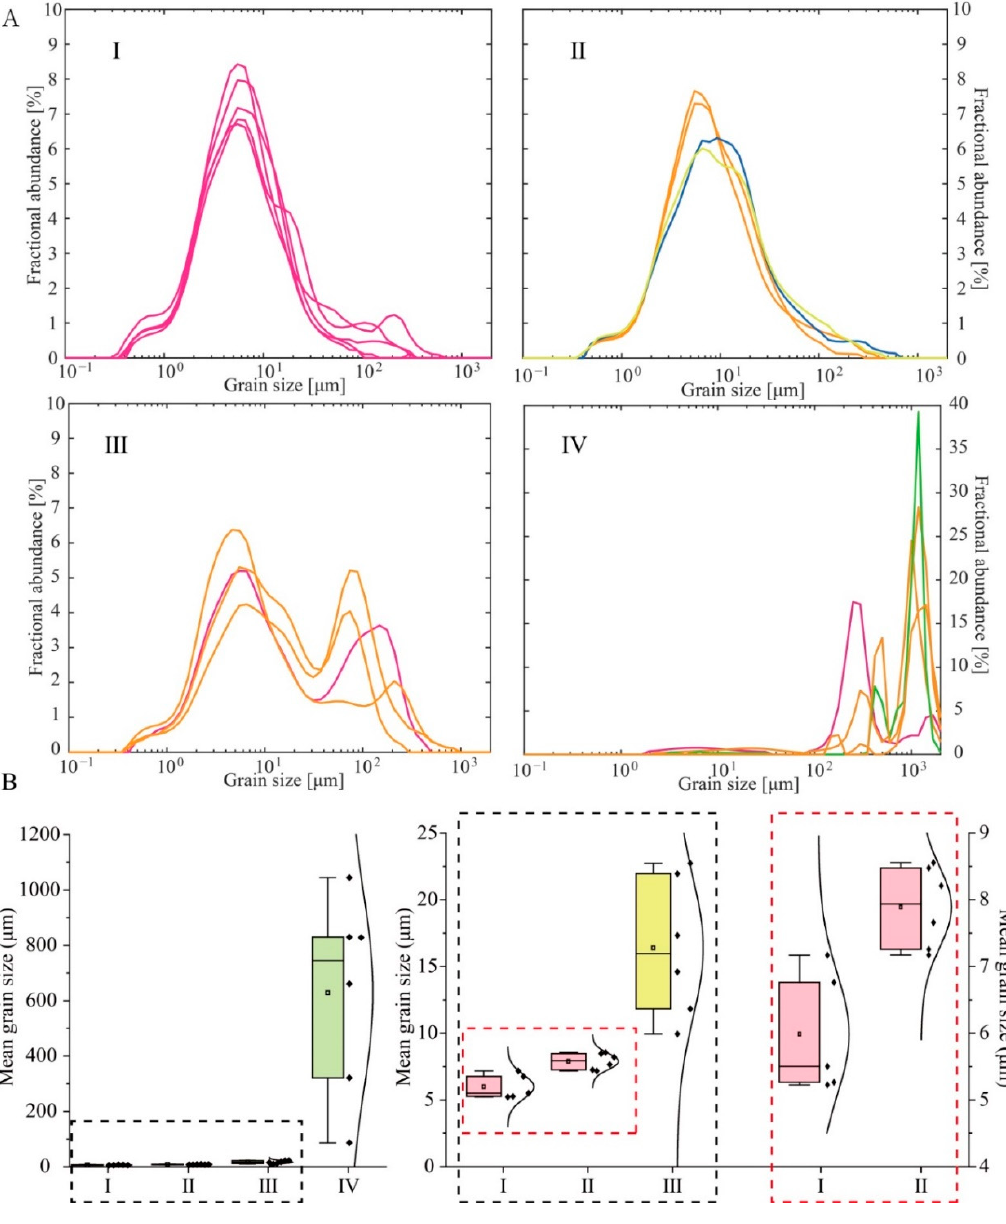
Figure 4. Sediment grain size frequency curve ( A ) and average grain size distribution ( B ). I, II, III and IV in the figure correspond to mud, silt, sandy silt and sand sediment types in the Folk sediment classification diagram, respectively. The curves in the four rectangles in zone A are grain size distribution curves of the samples, and the color of the curves corresponds to the color of the partitions in the Folk sediment classification diagram. The black and red dashed rectangles in area B are the enlarged portions of the